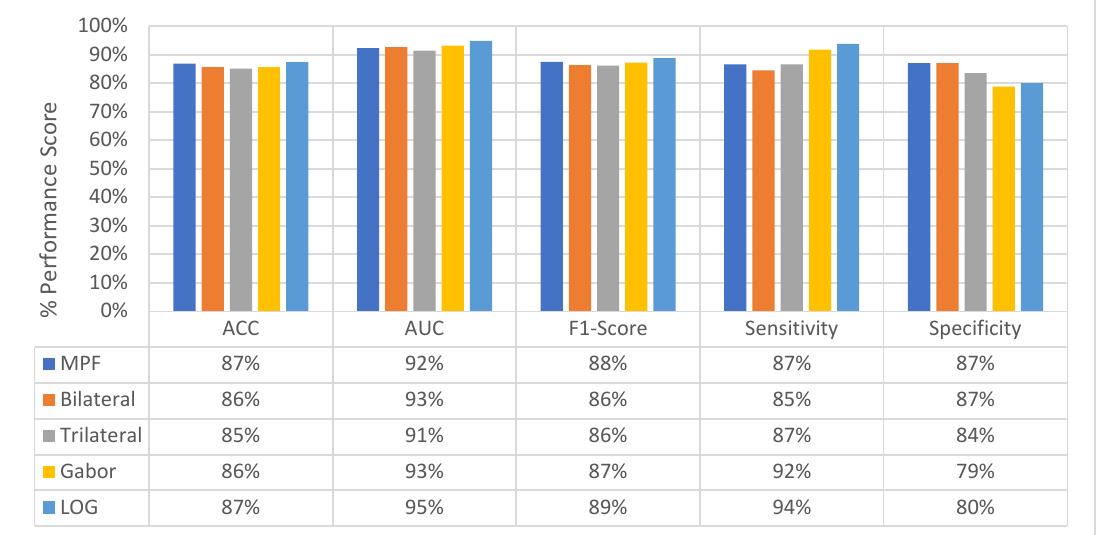
Figure 37. Change in volume-level classification performances for the proposed classifiers.